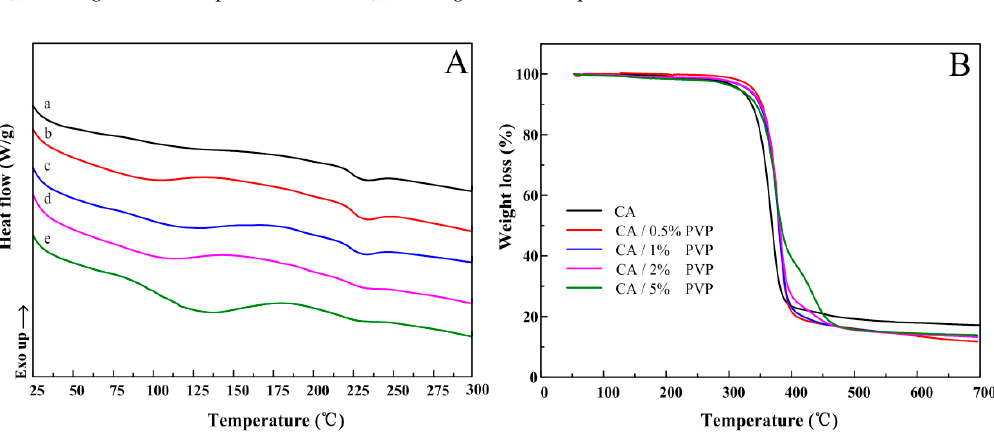
Table 2. TGA curves of CA/PVP hybrid nanofibers analysis results *.